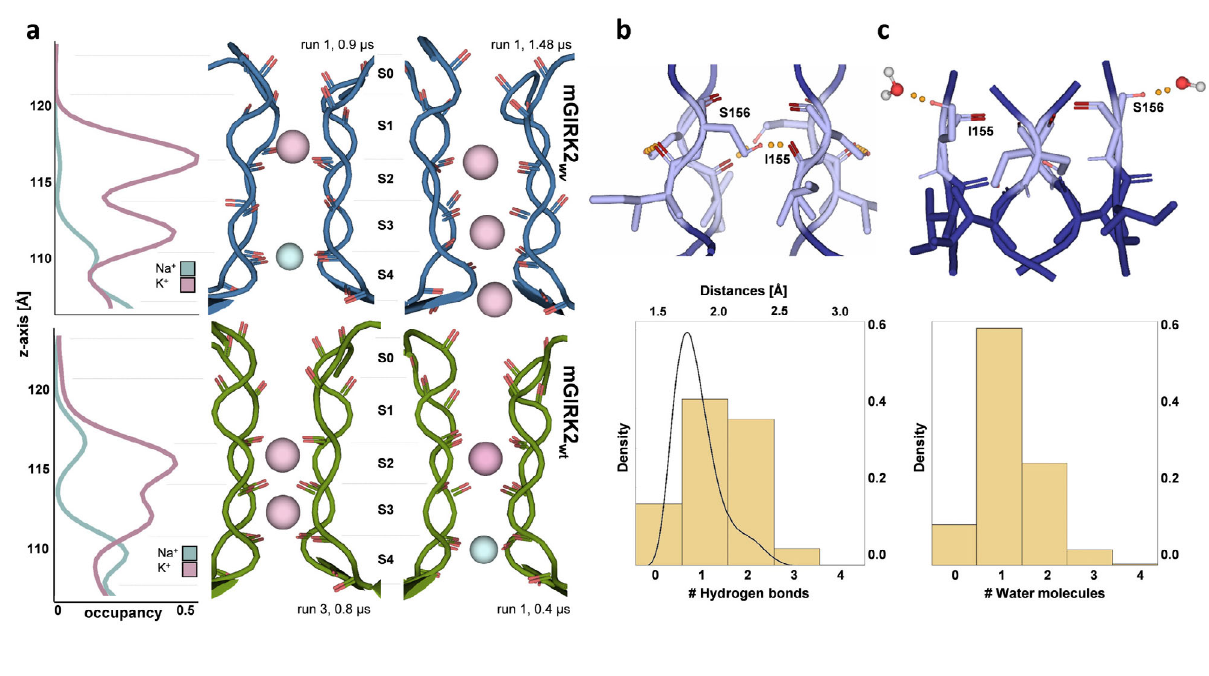
Fig. 5 Differences in ion occupancies and in the hydrogen bond network between mGIRK2 wt and mGIRK2 wv . a Top: Ion occupancies in the mGIRK2 wv SF observed over a total of 9 µ s-long MD simulation. Two characteristic snapshots of Na + and K + permeation are shown on the right. Bottom: Ion occupancies in the wild-type SF observed over 6 µ s long MD simulations. The snapshots on the right show a characteristic K + occupancy pattern as well as Na + block between sites S3 and S4. b Top: Representative snapshot of hydrogen bonds between the sidechain of S156 and the backbone oxygen of I155 in the mGIRK2 wv SF. Bottom: Density distribution of the distances and the numbers of hydrogen bonds between the sidechain of S156 and the backbone oxygen of I155 observed over 9 µ s simulations with GIRK2 wv . c Top: Representative snapshot of hydrogen bonds between the sidechain of S156 and a water behind the mGIRK2 wv SF. Bottom: Histogram of the number of water molecules behind the SF, which form hydrogen bonds to the sidechain of S156, over 9 µ s simulations with mGIRK2 wv